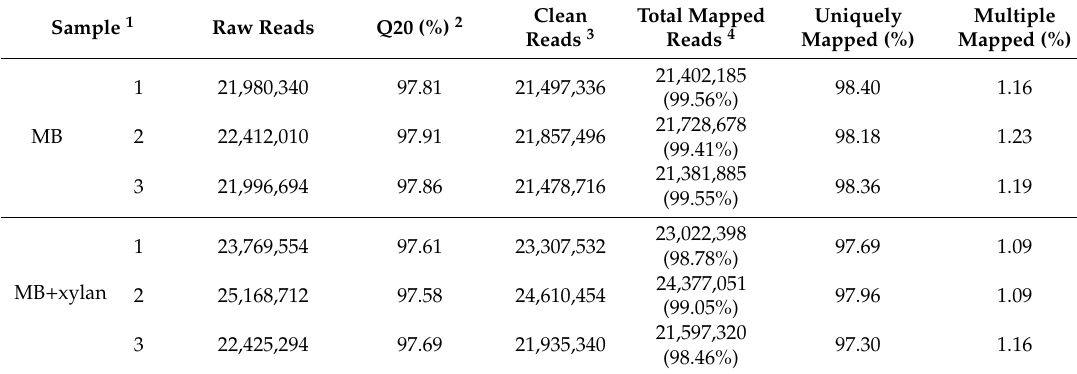
Table 2. Statistics information of the six RNA-seq datasets.